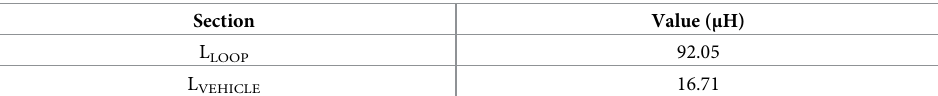
Table 8. Results for Citroe¨n C-15.